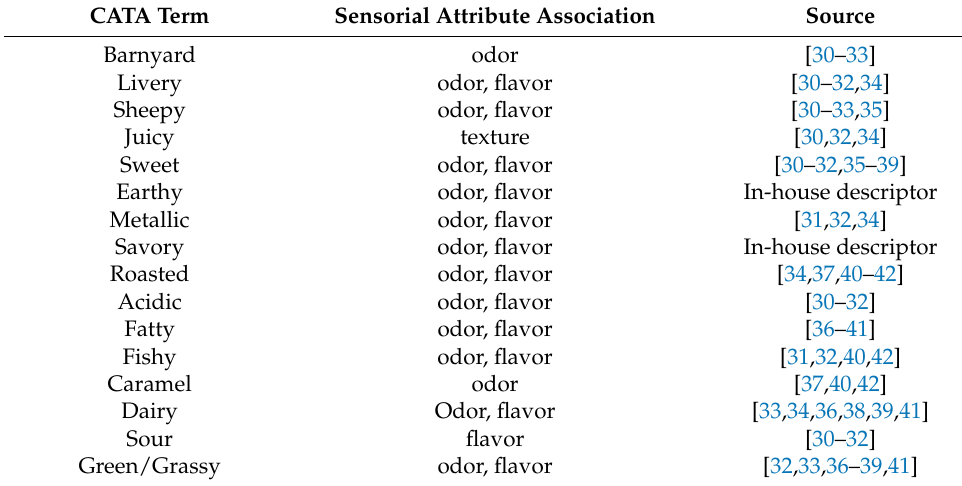
Table 1. CATA (check-all-that-apply) terms and